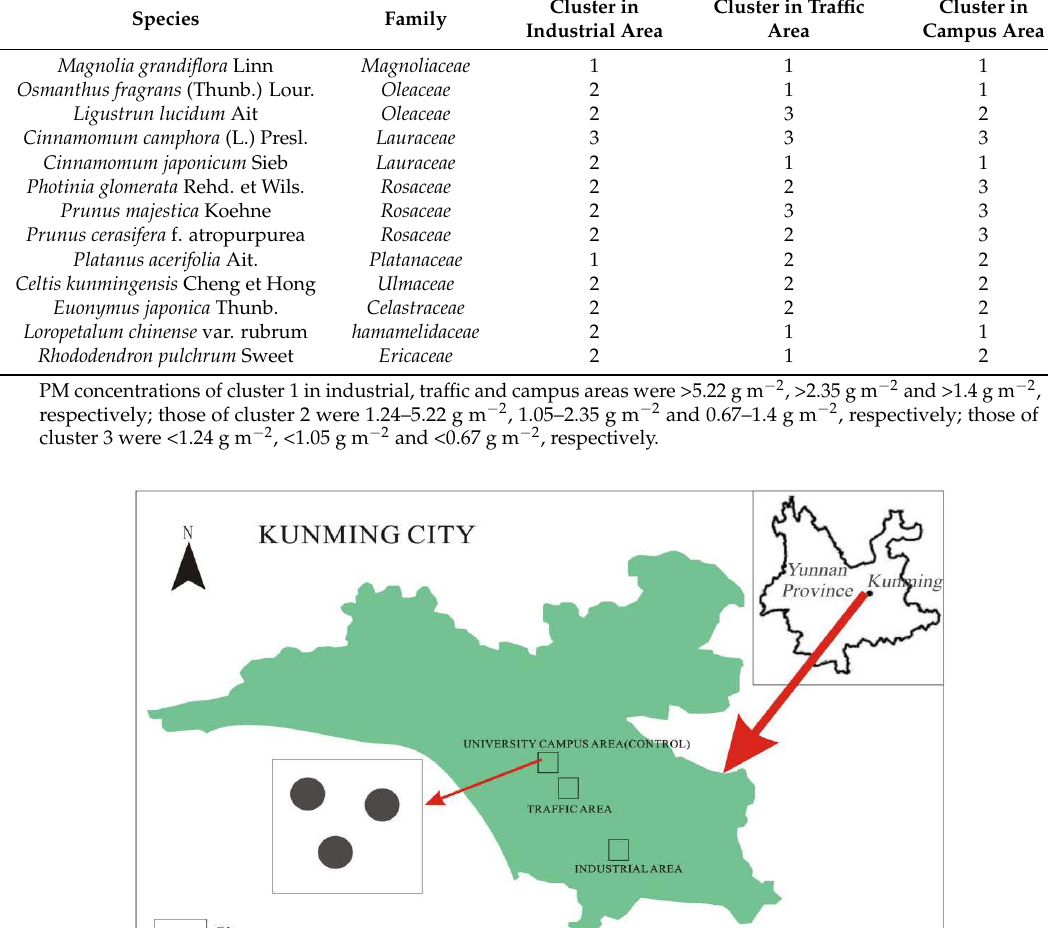
Table 1. Plant species used and clustering analysis with the surface accumulation of particulate matter (PM) as variables.